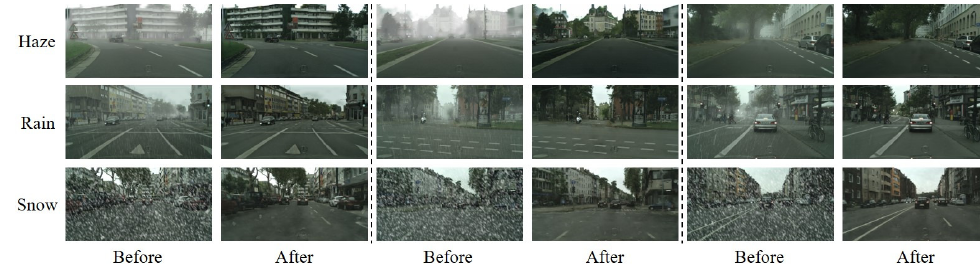
Figure 7. Weather removal results for the Cityscapes datasets. Although the MWTG model uses an unpaired training paradigm, the original Cityscapes dataset contains ground truth images for its synthesized weather datasets, in contrast to the RDSBW dataset. The result is that even if objects are occluded by haze, rain, or snowflakes, MWTG still can recover the original Cityscape images to generate clear images.